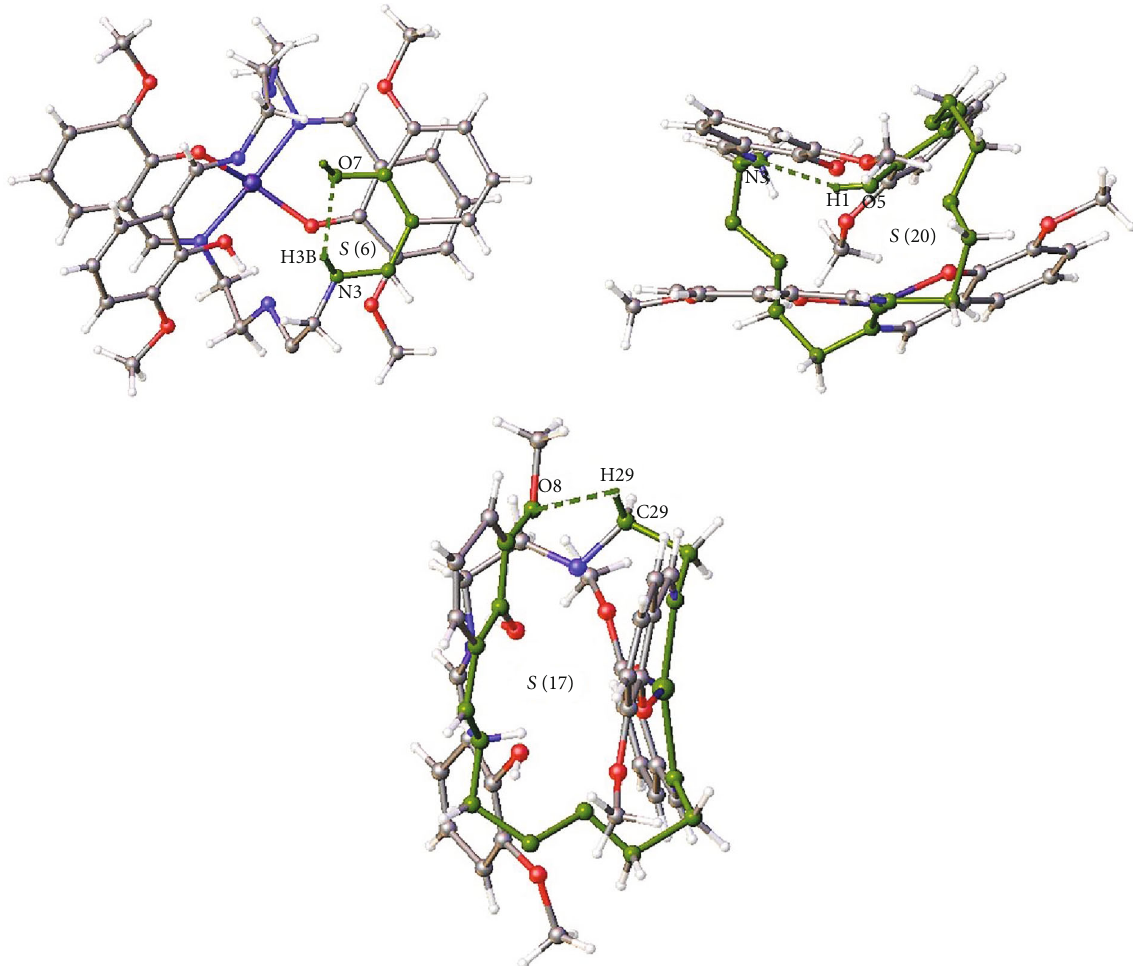
Figure 3: Illustration of S (20), S (6), and S (17) graph sets in the Cu(H